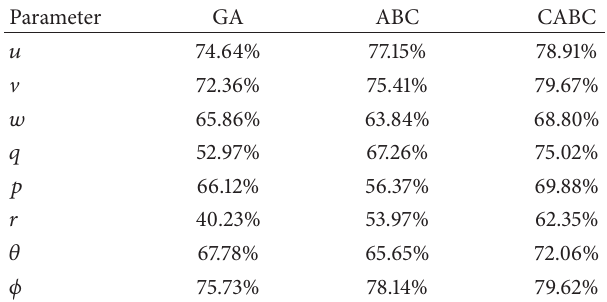
Table 6: Comparison of math